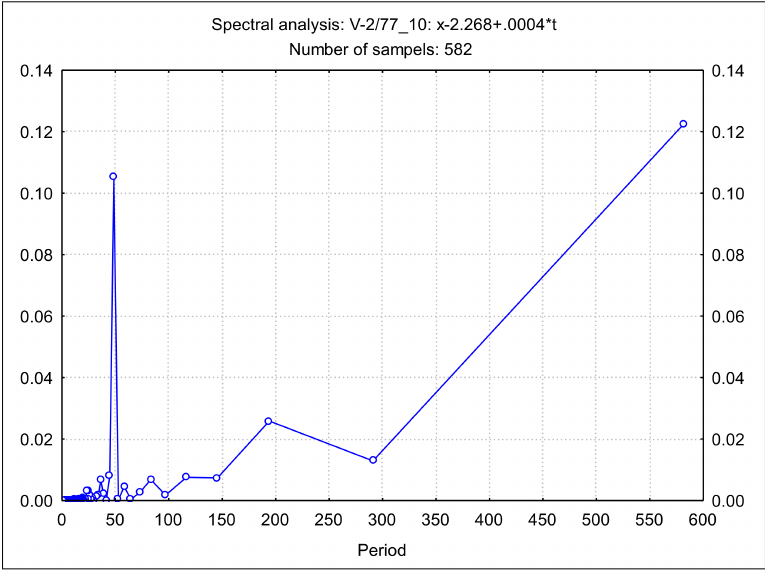
Figure 7. Fourier analysis of groundwater oscillation in piezometer